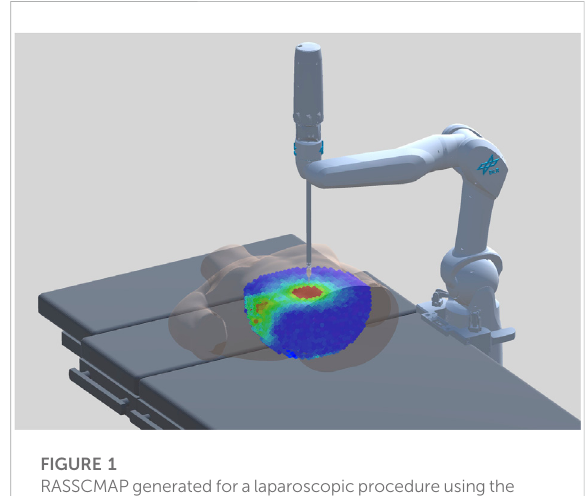
FIGURE 1 RASSCMAPgeneratedforalaparoscopicprocedureusingthe DLR MiroSurge